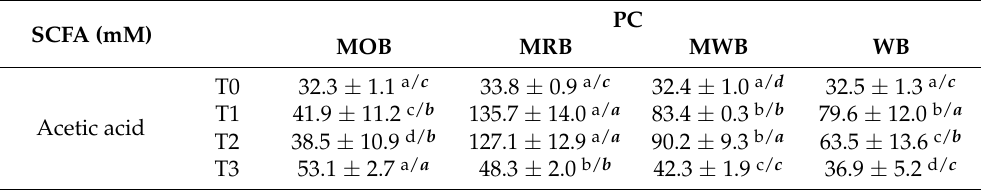
Table 2. SCFAs concentration (mM) in PC and DC reactors before (T0), after one (T1) and two (T2) weeks of treatment period and after two weeks of wash out period (T3). The 4-SHIME ® units (1, 2, 3 and 4 units) were treated with MOB, MRB, MWB and WB,